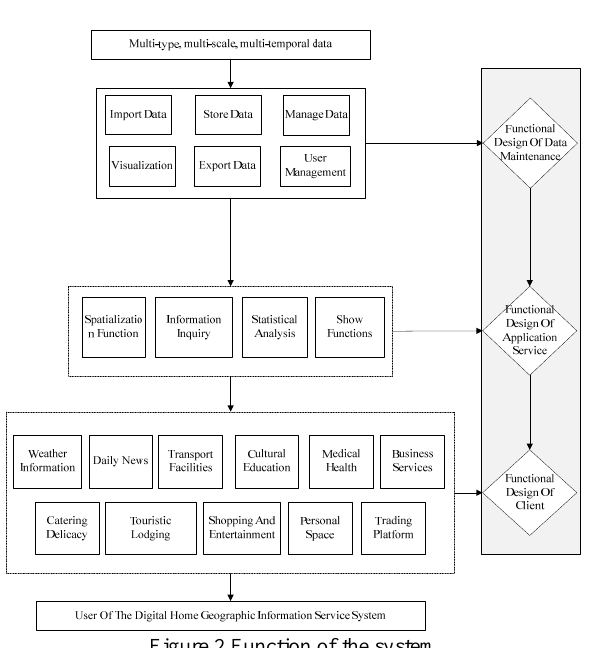
Figure 2 Function of the